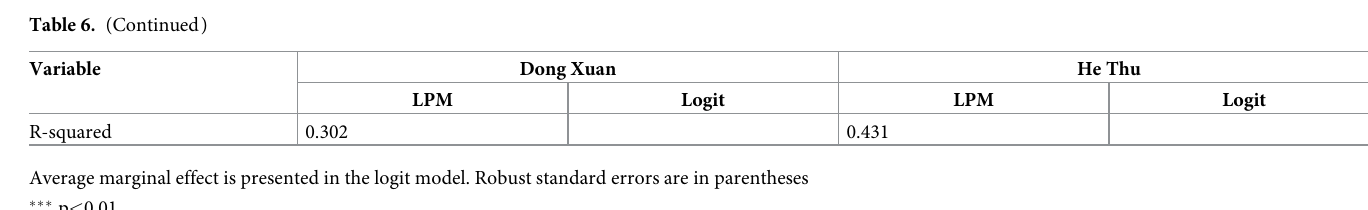
Salt tolerant rice variety adoption is one just one, rather limited, adaptation to climate